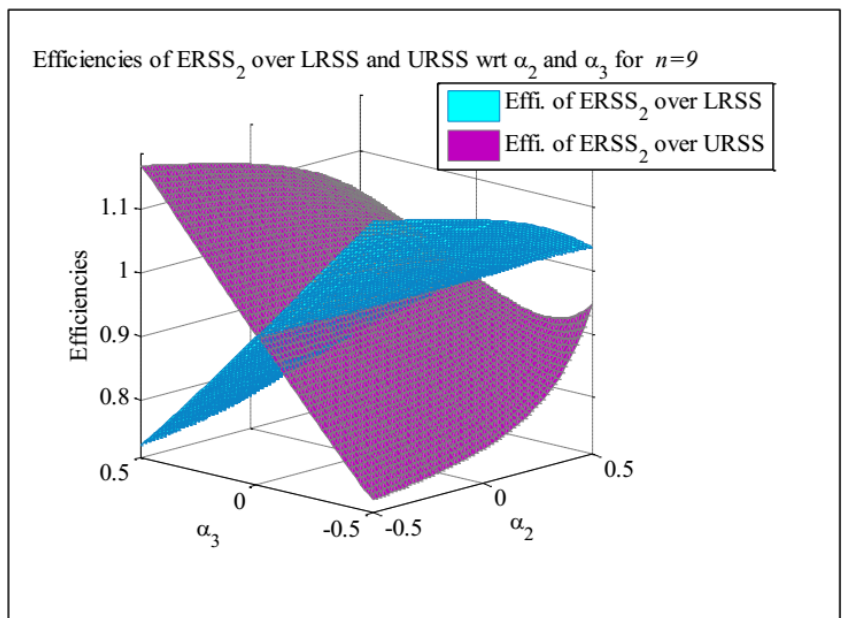
over ˆ θ and ˆ θ for n = 2,ERSS 2 2,LRSS 2,URSS